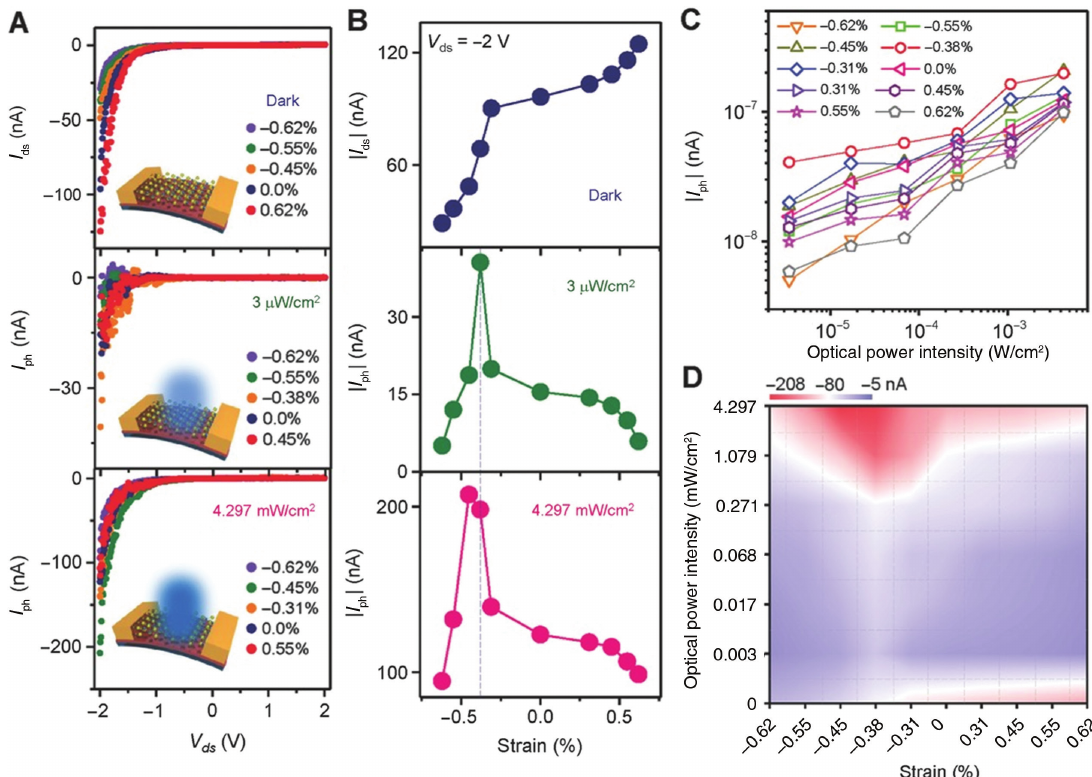
photodetector. Figure 12: Piezophototronic effects of monolayer MoS 2 (A) Electrical transport of photodetector in the dark under different strains (top). Photocurrents of the detector under strains with illumination intensity of 3 μ W/cm 2 (middle) and 4.297 mW/cm 2 (bottom). (B) Strain-dependent dark current (top) and photocurrents (middle, bottom) for the detector under drain bias of −2 V. (C) Relative change of photocurrents by strain modulation under different power intensities. (D) Piezophototronic mapping of photocurrents in the detector under different strains and power intensities. Reprinted with permission of Ref.